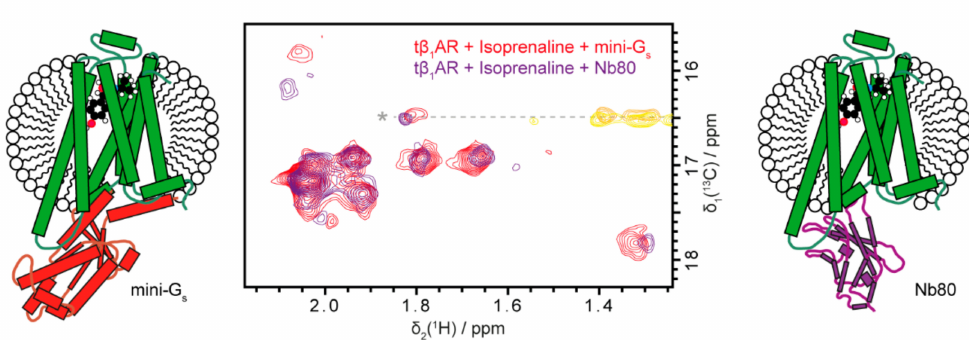
Figure 4. Nb80 and mini-G s cause highly similar spectral changes after binding to t β 1 AR. The obtained chemical shift patterns and signal shapes of the receptor are similar for the complexes formed with mini-G s (red spectrum, left scheme) and Nb80 (purple, right), indicating the same induced active conformation for both G protein surrogates. The same conditions as in Figure 2 were used. The complex with Nb80 was formed by addition of two-fold stochiometric excess of the nanobody to the agonist-bound